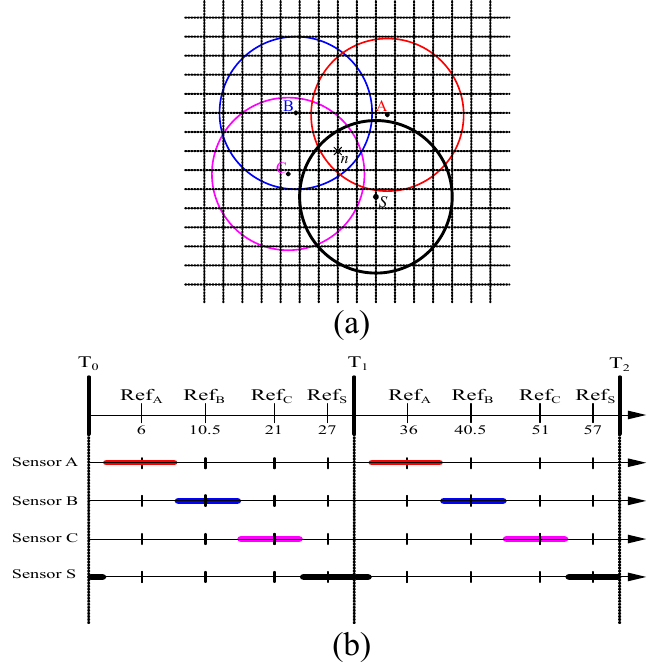
Figure 1. An illustration of the pre-scheduled grid-based algorithm. ( a ) The division of sensing range of sensor s into multiple Grid Points (GPs), in which grid point n is also covered by sensors A , B and C . ( b ) Sensors A , B , C and S establish the duty cycle for grid point n